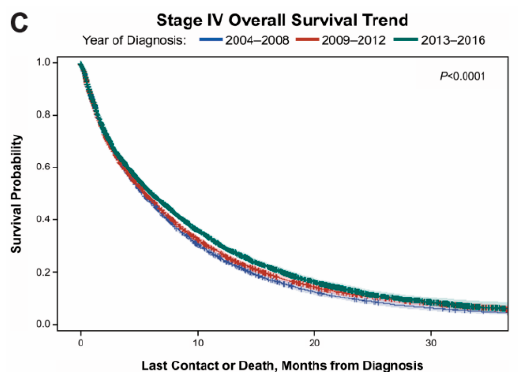
Figure 2. Kaplan-Meier analysis of all stages of gastric cancer 3-year overall survival stratified by year of diagnosis; 2004–2008, 2009–2012 or 2013–2016. For Stage I ( A ), Stage II / III ( B ) and Stage IV ( C )